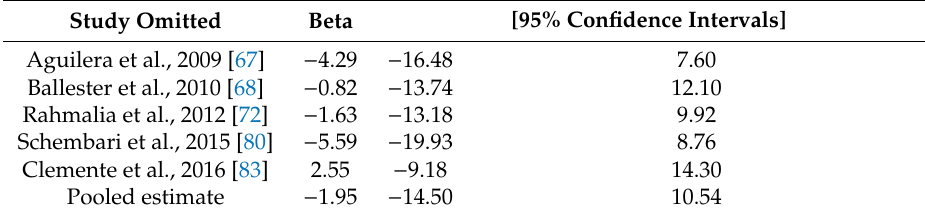
Table A1. Sensitivity analysis: birth weight and NO 2 exposure during the third trimester of pregnancy.